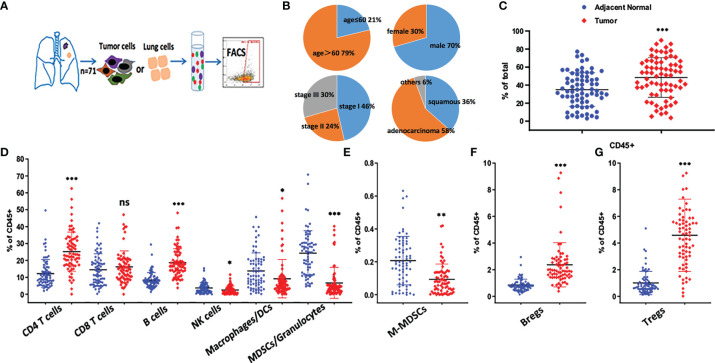
Immune profiling of NSCLC tumor microenvironment. (A) Overview of the study design. Fresh surgical resections of adjacent normal lung and tumor tissues were collected from patients. Tissue samples were digested into single cell suspensions for the following staining. The data was analyzed either by flow cytometry. (B) Demographic information of the patients was shown. In total, 71 paired samples were collected. (C) The percentage of CD45+ cells were compared between adjacent normal lung and tumor tissue samples, ***p < 0.001 by paired t-test. Dot plots show Mean ± SD. (D–G) Frequency of immune subsets based on the following phenotypical markers, CD4 T cells (CD3+CD4+), CD8 T cells (CD3+CD8+), B cells (CD19+), NK cells (CD56+), Macrophages/DCs (CD11b+CD11chighHLA-DR+), MDSCs/Granulocytes (CD11b+CD11clowHLA-DR-), M-MDSC (CD11b+CD11clowHLA-DR-CD14+CD15-), Bregs (CD19+CD38+CD24+), Tregs (CD3+CD4+CD25+CD127low), ns p > 0.05, *p < 0.05, **p < 0.01, ***p < 0.001 by paired t-test. Dot plots show Mean ± SD.